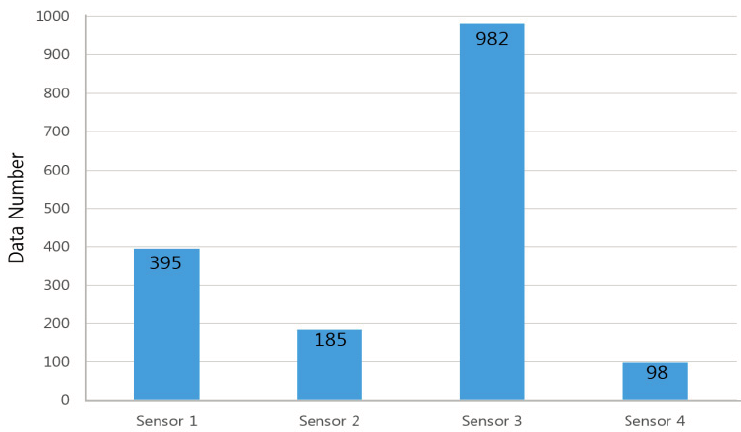
Figure 8. Frequency of sensor removal by the data